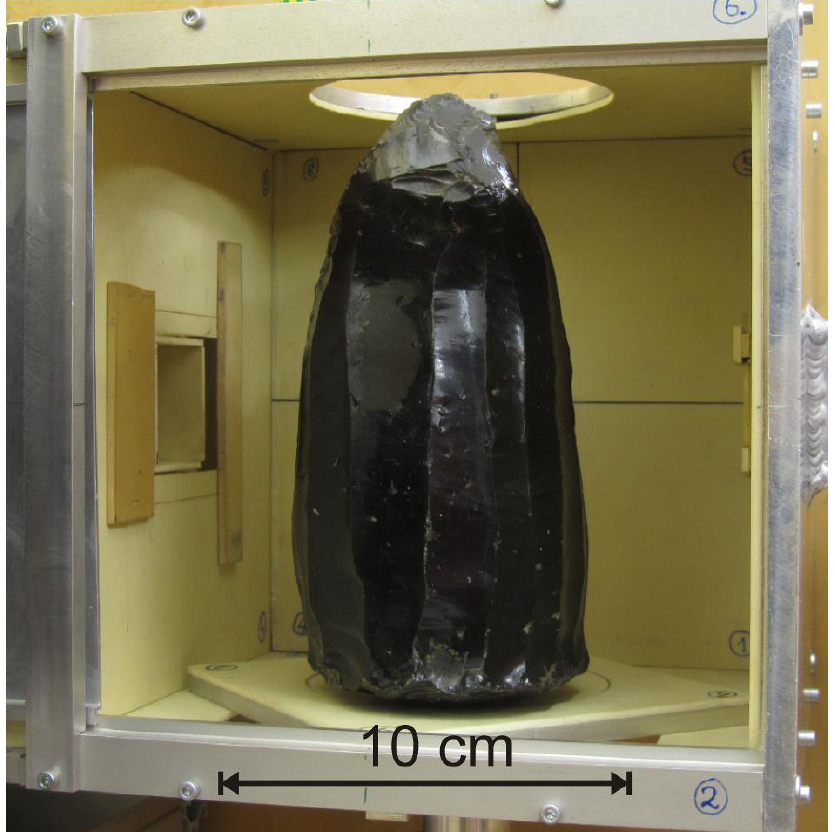
Figure 4. An obsidian core in the sample holder of the Budapest NIPS-NORMA